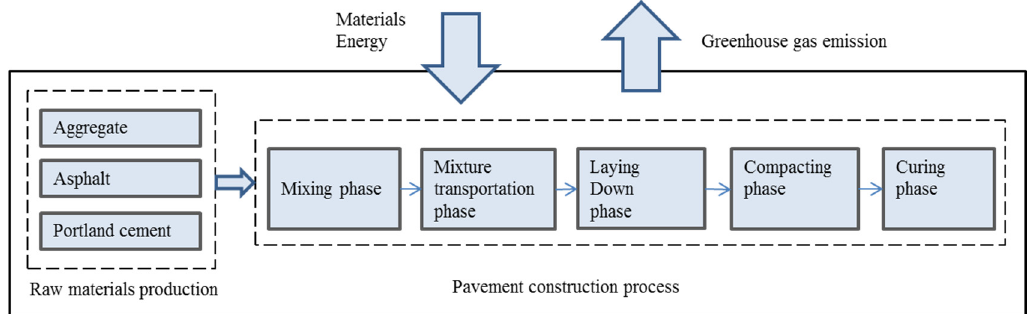
Figure 1. Evaluation system boundary of GHG emissions for asphalt pavement construction.